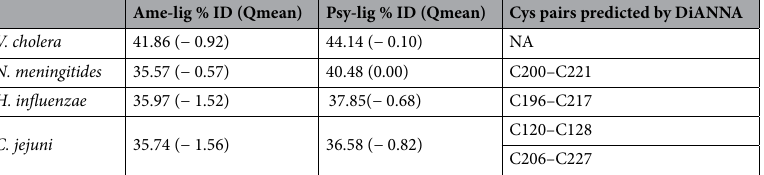
Table 2. Sequence identity and quality scores of homology models for pathogen Lig Es based on structurally- characterized representatives in the DNA-bound (Ame-lig) and DNA-free (Psy-lig) conformations. Disulfide connectivity is predicted by highest-scoring cysteine pairs from DiANNA.